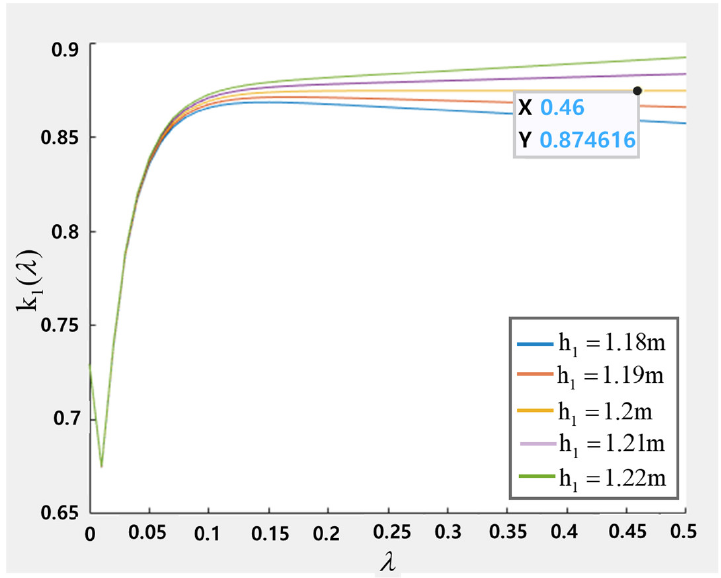
Figure 5.   (λ) by the different ℎ  in Table 1.